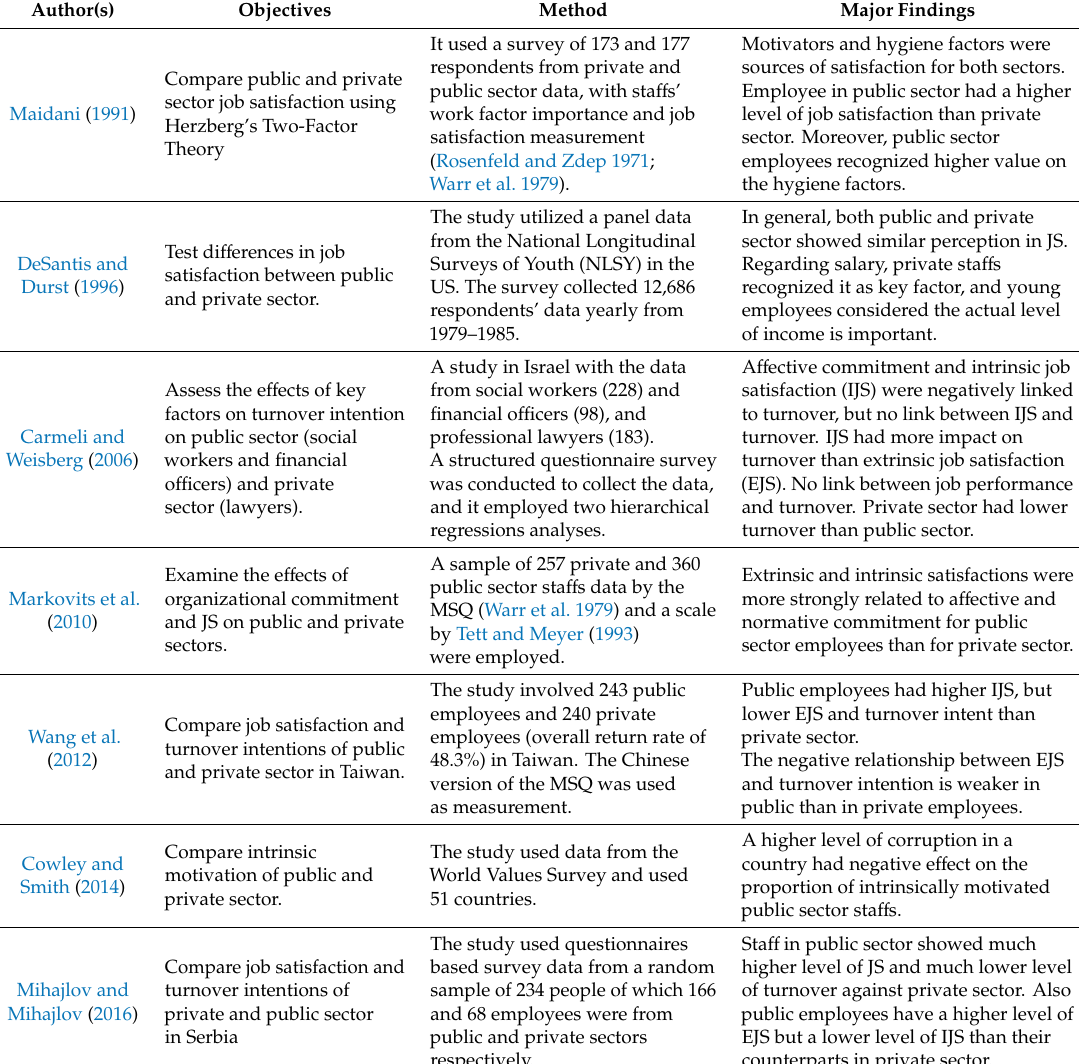
Table 1. A comparative study between public sector and private sector research on work motivation, job performance, job satisfaction, and turnover